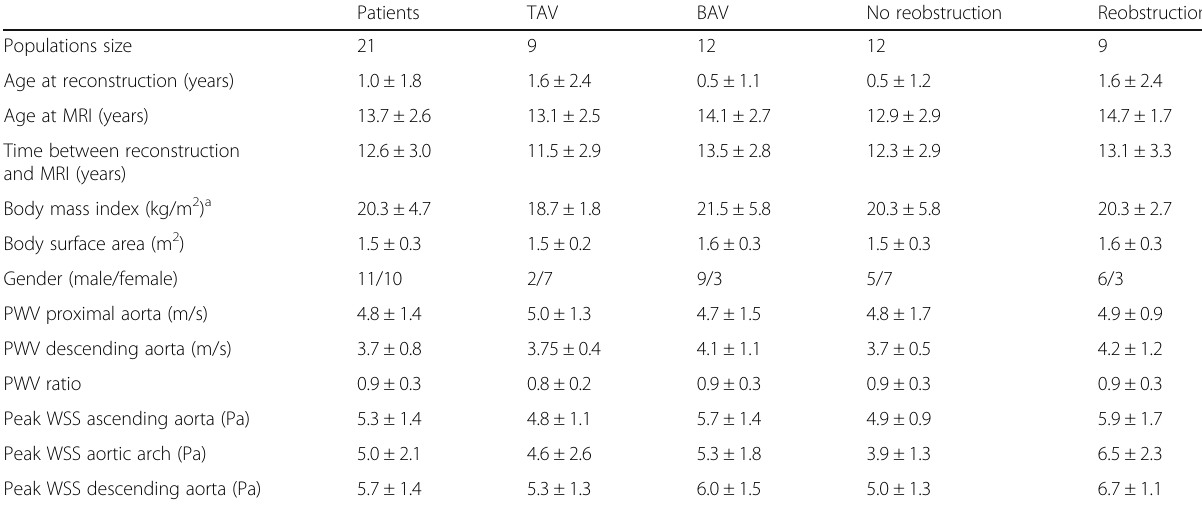
Table 1 Patient and subgroup